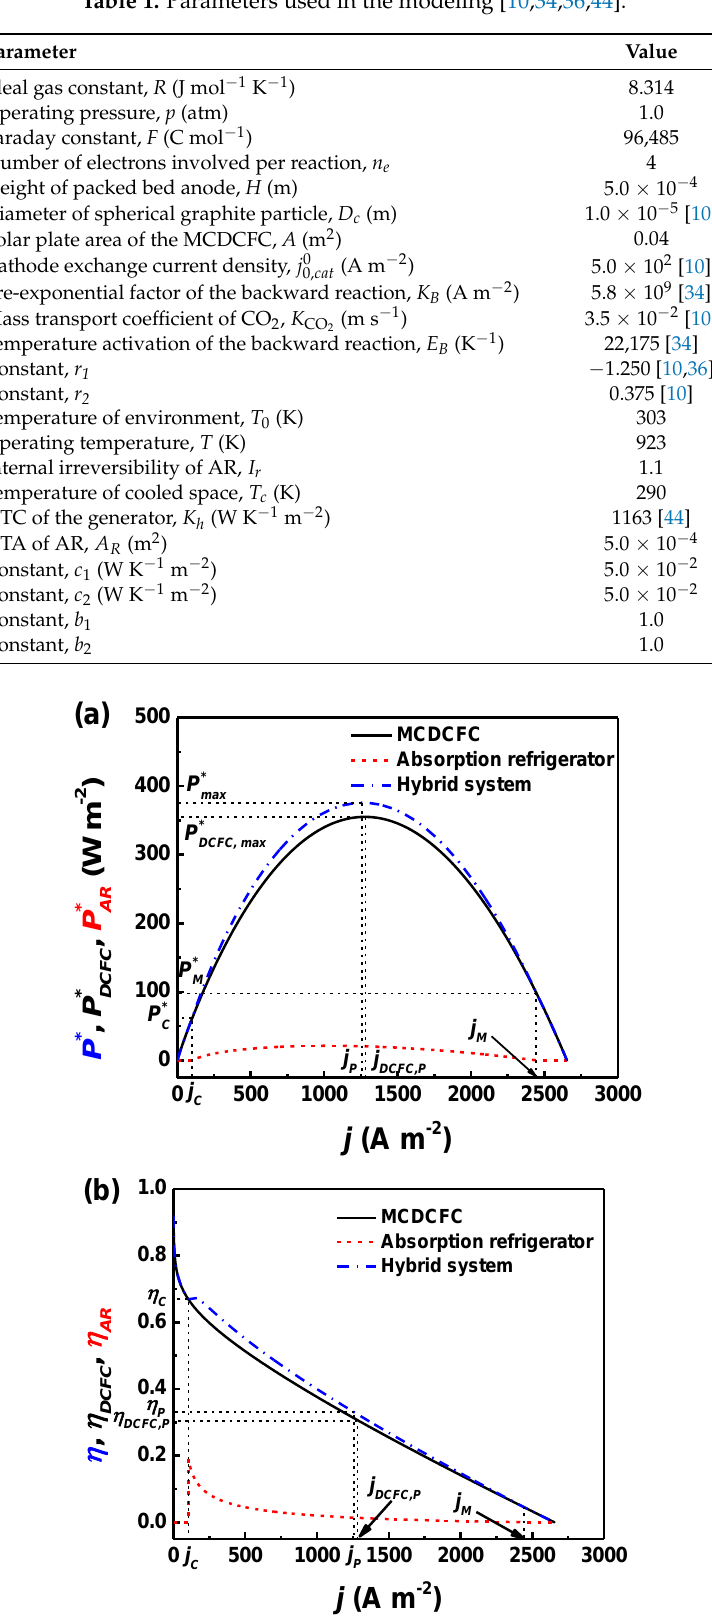
Table 1. Parameters used in the modeling [10,34,36,44].